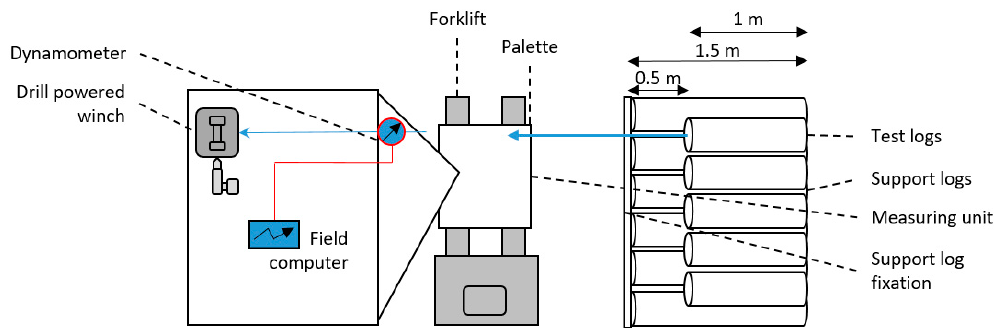
Figure 3. Schematic display of the test setup.